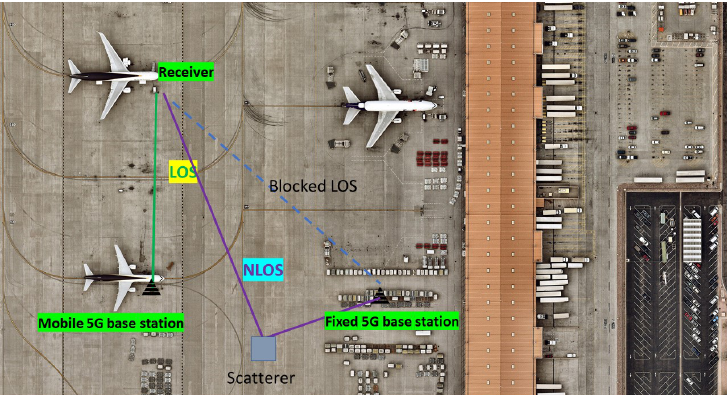
Figure 1. Example of an application area of the studied research question about LOS detection with 5G New Radio (NR). The continuous green line illustrates a LOS signal, the piece-wise continuous magenta line illustrates a NLOS signal, and the dashed blue line illustrates a signal that will be blocked before reaching the